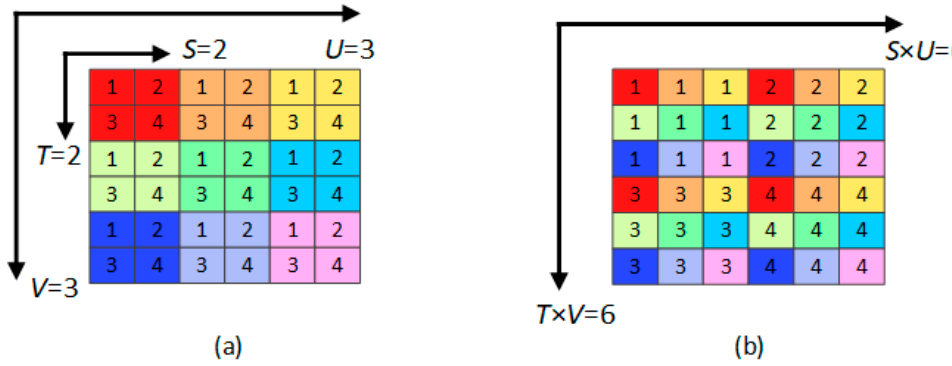
Figure 3. Raw LF image reconstruction: ( a ) A simple case of 3 × 3 views of LF where each view is represented by one color and contains 4 pixels numbered 1–4, ( b ) The mapping from the LF array of views with size ( u , v , s , t ) into raw LF image of size ( u × s , v × t ).